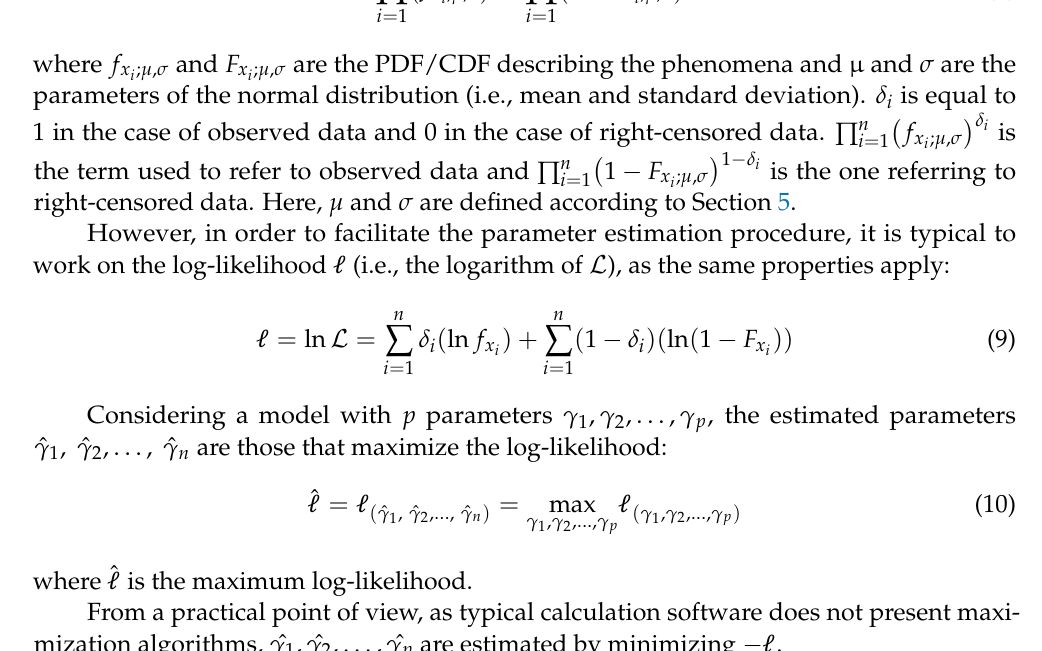
Figure A1. Example of LP and LR for 𝑠 𝑙𝑜𝑔(𝜎 𝐹0 ) . The usage of PF allows for the description of the confidence interval of the parameter in its natural range [61,63,64] via the usage of the Likelihood Ratio (LR). It is possible to demonstrate that the ratio between ℓ̂ and ℓ 𝛾̅ 1 can be related to a 𝜒 2 distribution with one degree of freedom [82]: